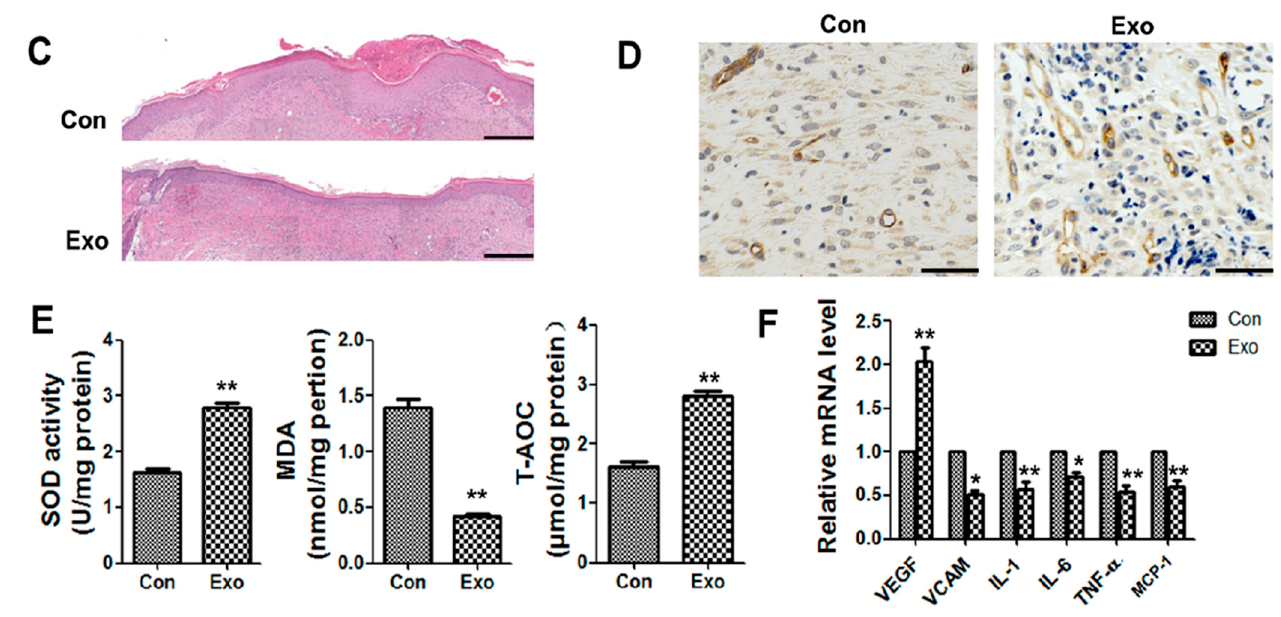
Figure 2. Effects of ADSC-exos on wound healing in db/db model mice. ( A ) Digital images of wound areas treated with PBS or ADSC-exos on days 0, 1, 3, 5, 7, 10, and 14 (scale = 1 cm). ( B ) Analysis of the